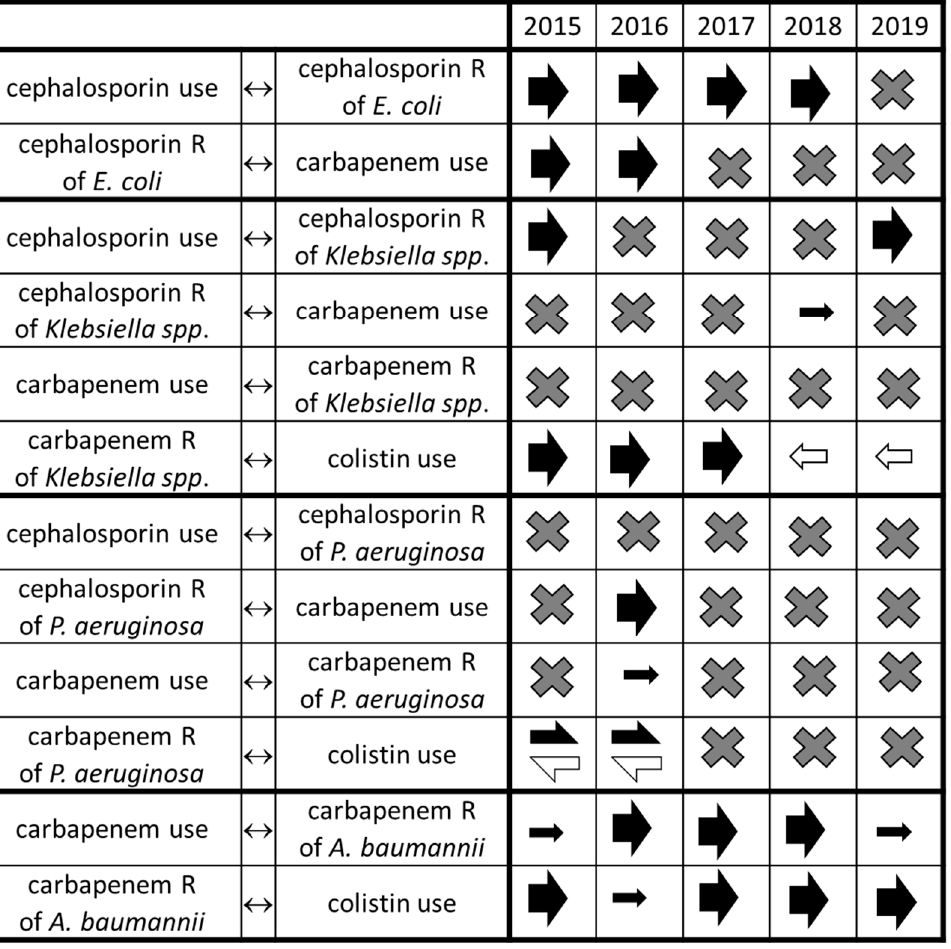
Figure 2. Relationships between antibiotic use and resistance in case of different species analyzed separately. X symbol: no significant relationship; filled arrows: positive relationship (effect on response is directly proportionate to the impulse), open arrows: negative relationship (effect on response is inversely proportionate to the impulse), directions of arrows show the direction of the relationship, i.e., arrows pointing right show that the left variable is the impulse and the right variable is the response, arrows pointing left mark the opposite.